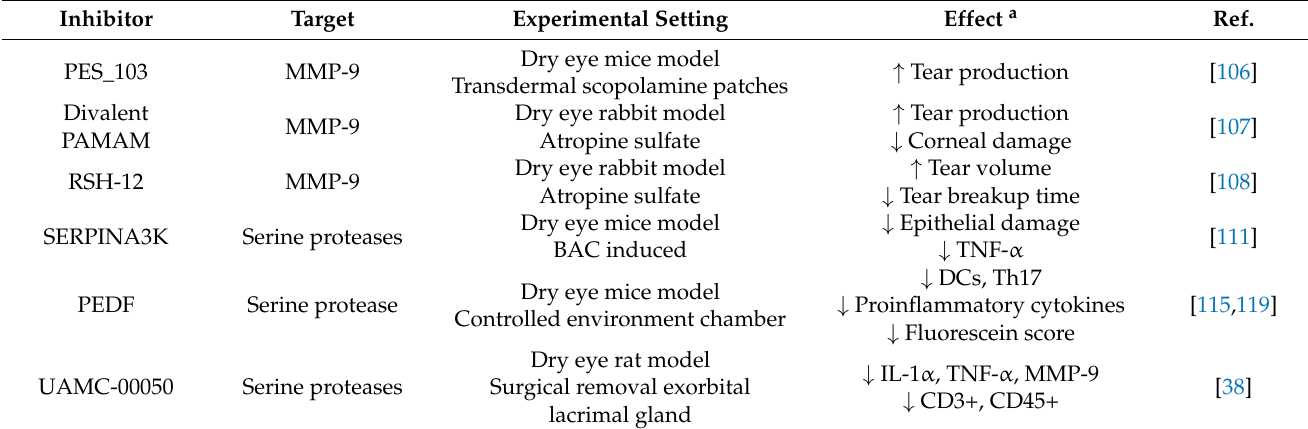
Table 1. Protease inhibitors and the effect they have in a specific experimental